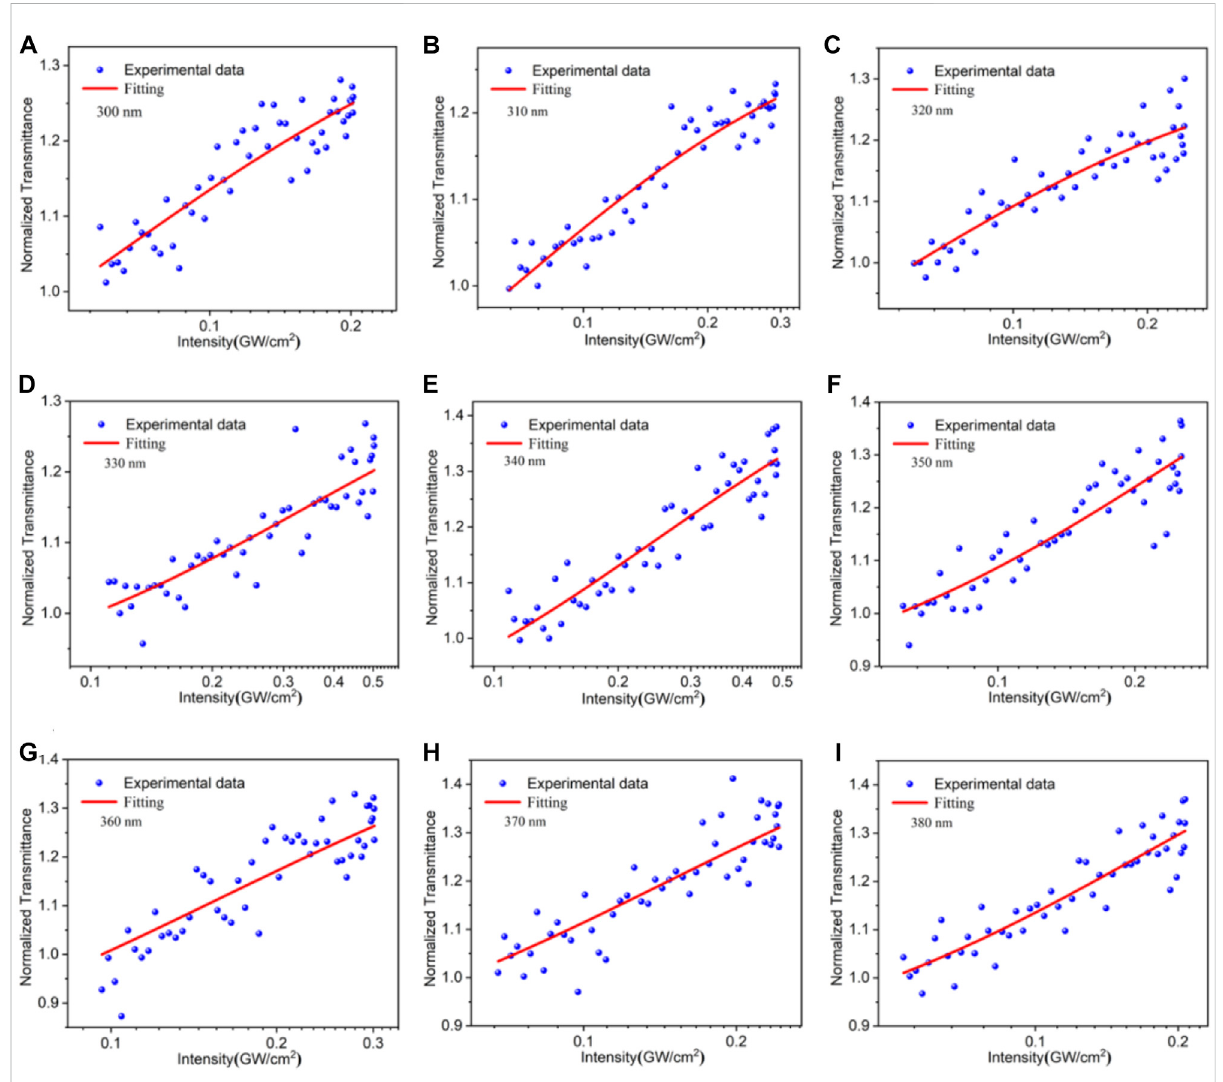
FIGURE 4 Fitting results of the saturable absorption intensity at different wavelengths. (A – I) : 300, 310, 320, 330, 340, 350, 360, 370, and 380